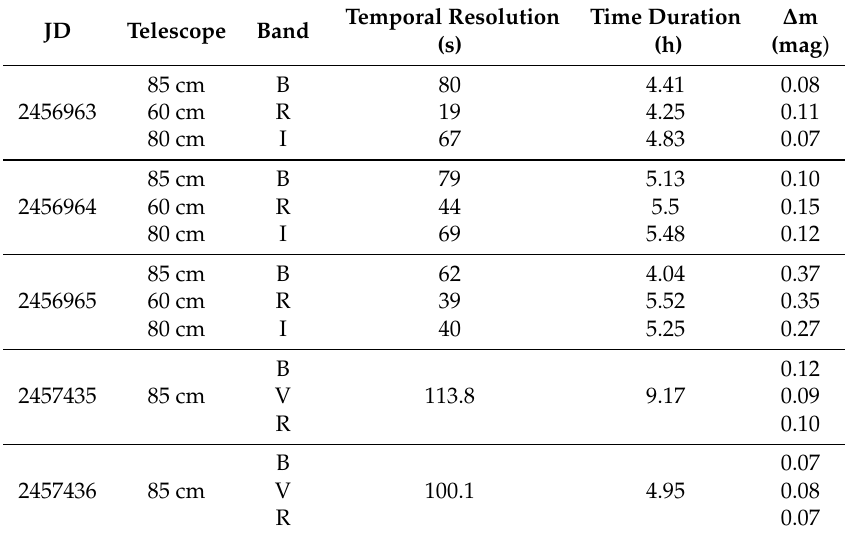
Table 1. Details of observations including observation date, telescope, filter, mean temporal resolution, time duration per night and amplitude of variation.